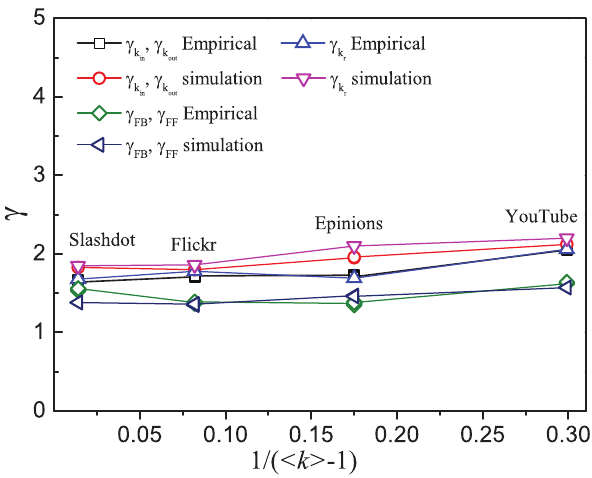
Figure 10. Values of the c -exponents for various distributions. Values of the c -exponents for the various distributions as determined by the maximum likelihood estimation against 1 = ( S k T { 1) for each of the four large-scale online social networks and the corresponding simulated networks based on the model. The lines are only guides to the eye.